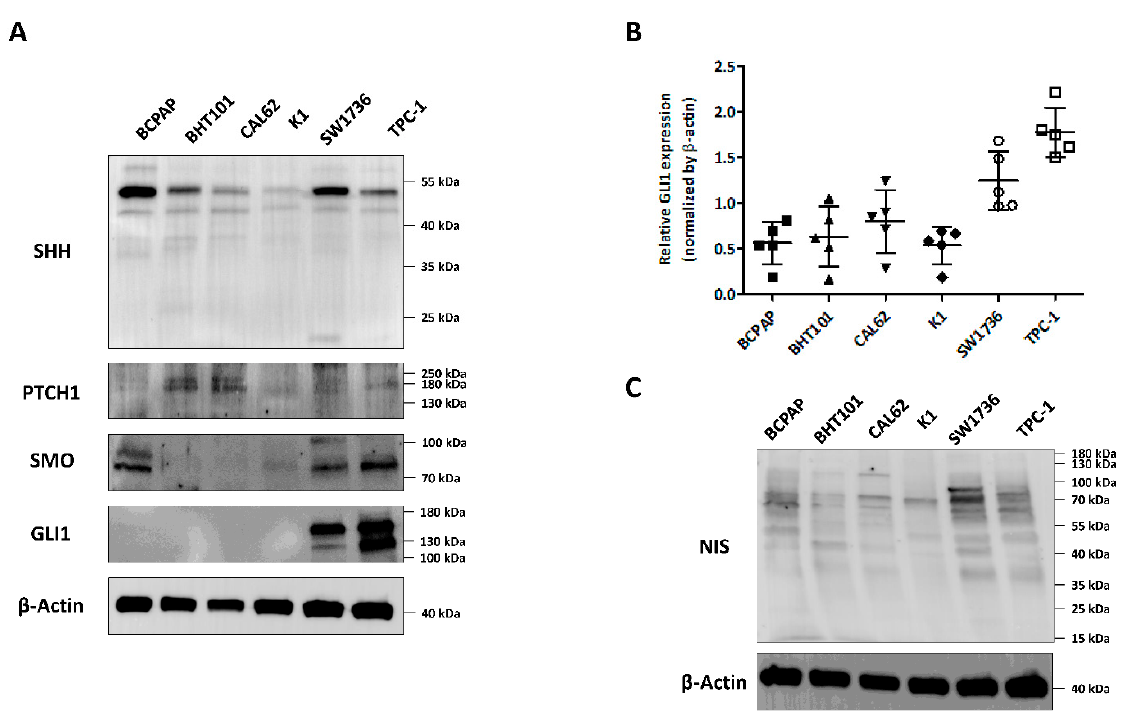
Figure 1. Investigation of hedgehog signaling pathway in thyroid cancer-derived cell lines. Three papillary thyroid cancer cell lines (BCPAP, K1, TPC-1) and three anaplastic thyroid cancer cell lines (BHT101, CAL62, SW1736) were subjected to western blot analysis. ( A ) Evaluation of the hedgehog signaling pathway. ( B ) Quantitative analysis of GLI1 expression in several thyroid cancer cell lines. ß-actin was used as an internal control. Mean ± standard deviation (SD) values from three independent experiments are presented. ( C ) Confirmation of NIS protein expression level in thyroid cancer-derived cell lines. ß-actin was used as an internal control. Raw data is presented in Figures S2–S4.